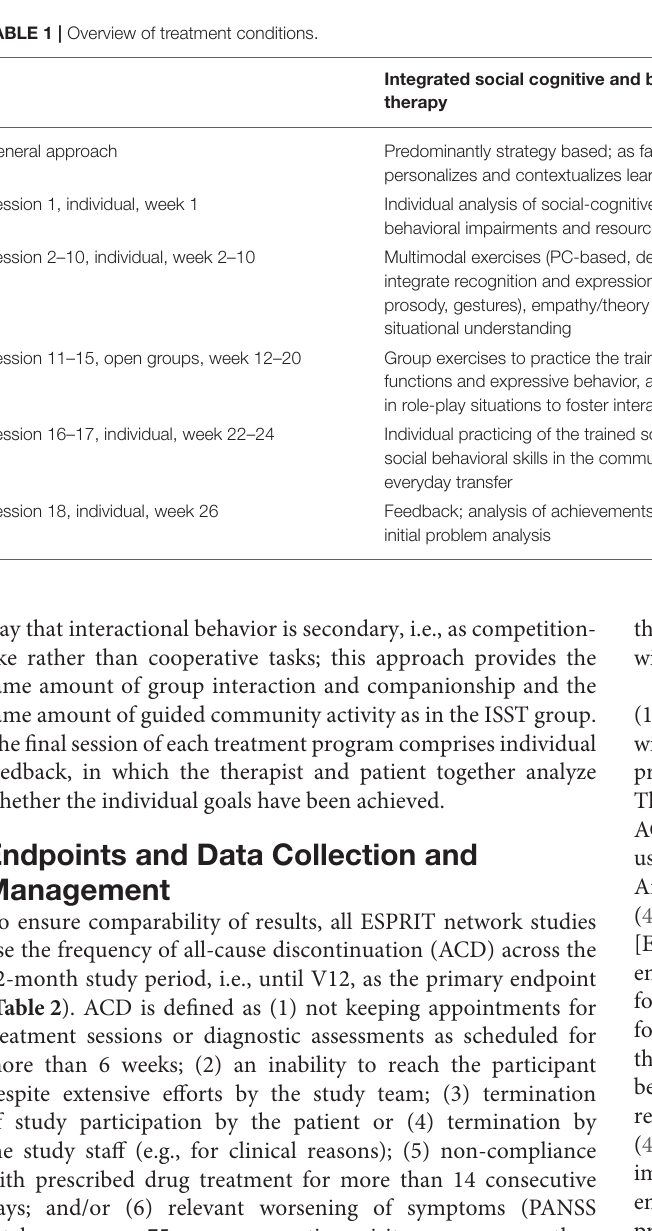
TABLE 1 | Overview of treatment conditions. General